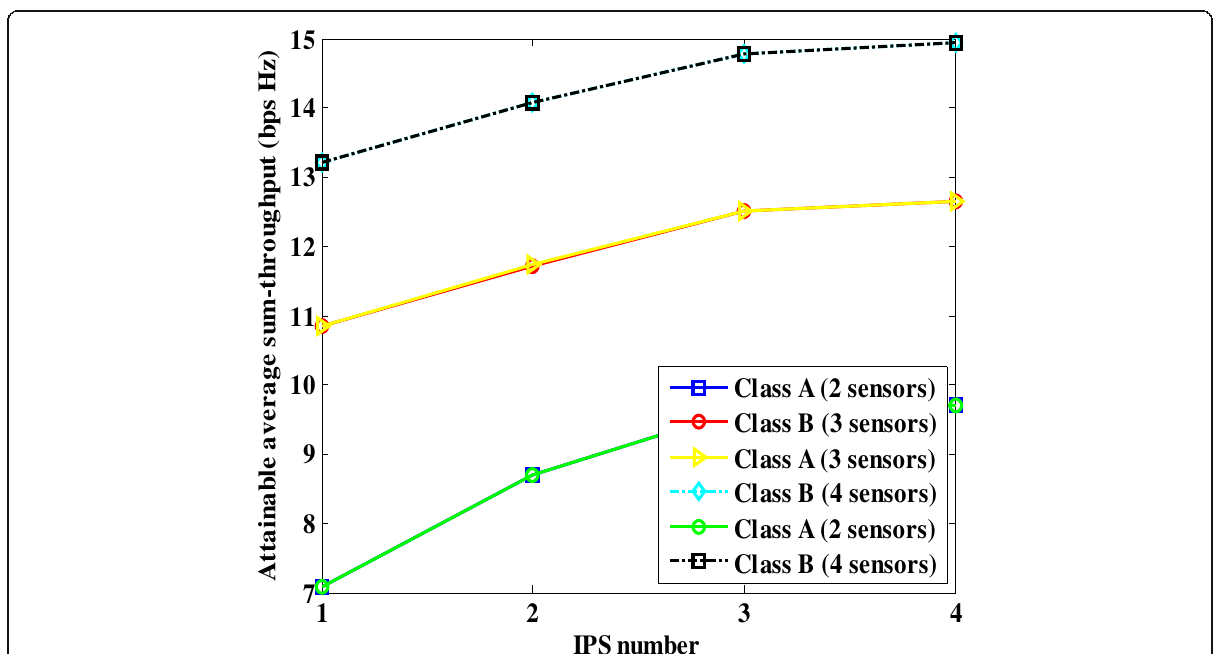
Fig. 12 Attainable sum-throughput based on different number of nodes in the network